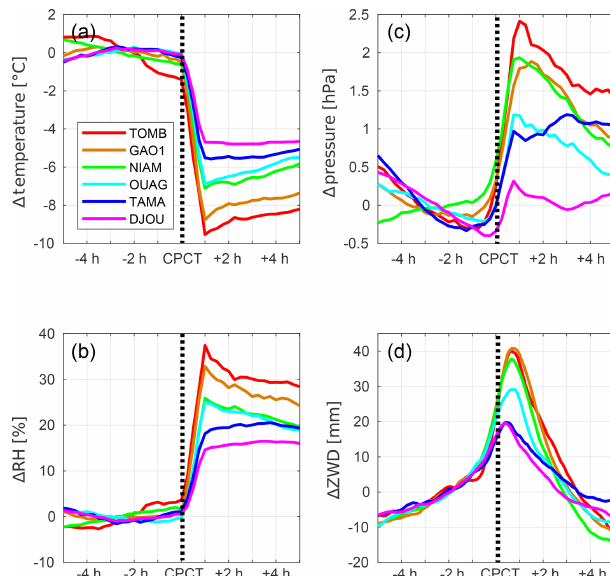
Figure 14. Same as Fig. 13 but variables are differentiated by the average values computed over the 5h period preceding the cold pool crossing time (CPCT). The average values are given in Table